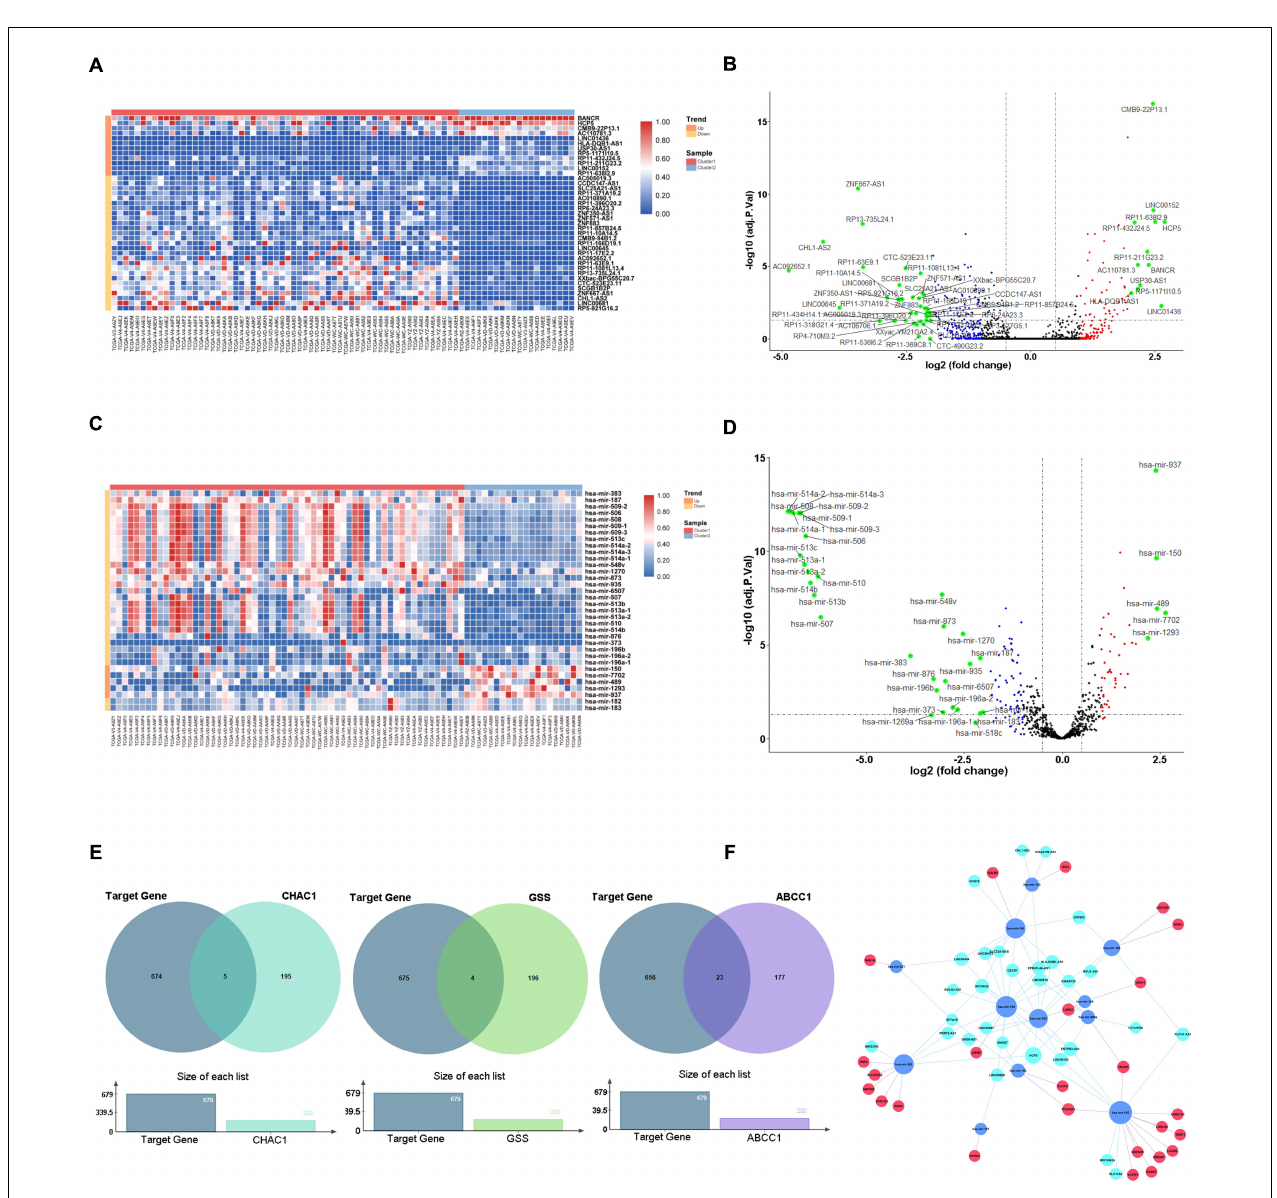
FIGURE 7 | Construction of ceRNA network key genes. (A) Heatmap of differential expression lncRNAs. (B) Volcano plot of differential expression lncRNAs. (C) Heatmap of differential expression miRNAs. (D) Volcano plot of differential expression miRNAs. (E) Venn plot of target mRNAs and highly associated ferroptosis-related regulators. (F) ceRNA building of the 29 lncRNAs (light blue) and 12 miRNAs (dark blue) and 25 mRNAs